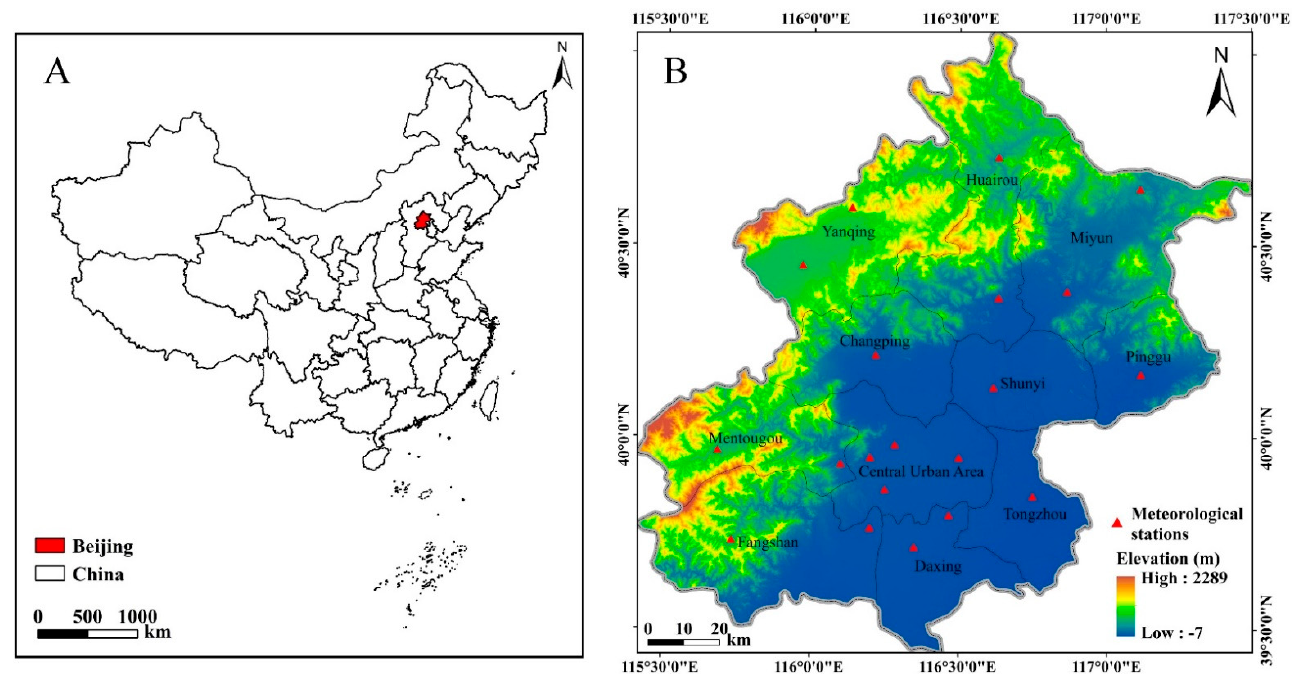
Figure 1. Geographical location map of the study area. Panel ( A ) presents the location of Beijing in China. Panel ( B ) shows the spatial extent, elevation, locations of 20 national meteorological stations, and boundaries and names of the districts in Beijing.